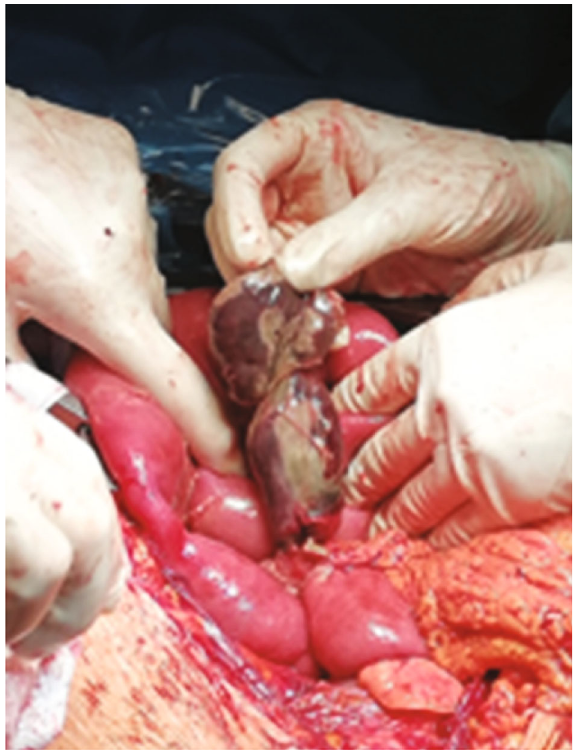
Figure 2: Perforation site of Meckel ’ s